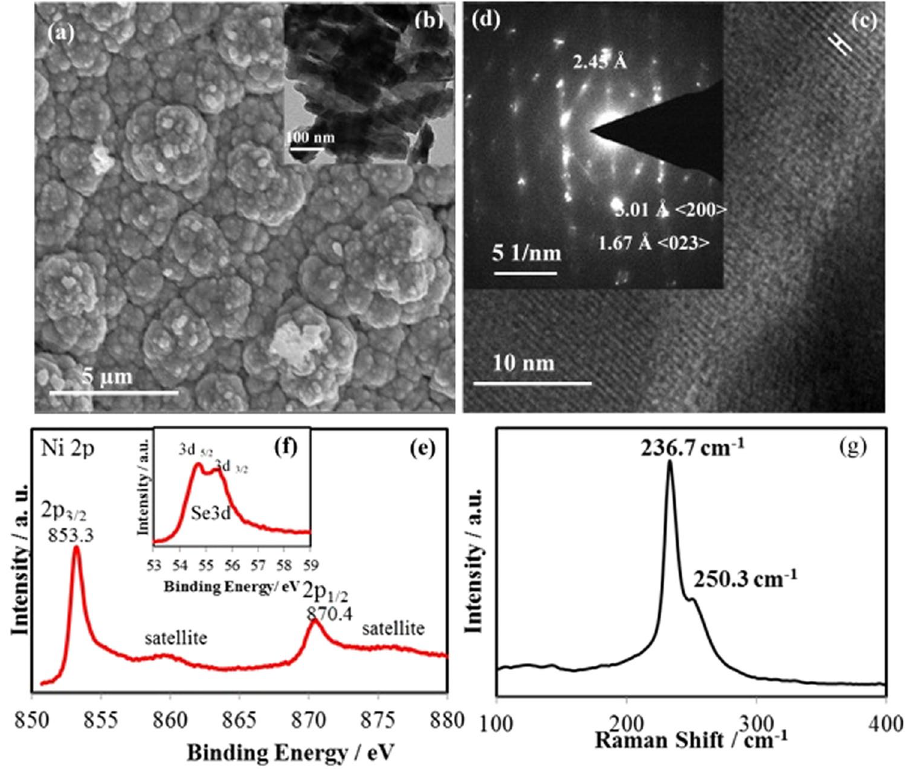
Figure 2. SEM ( a ) and TEM ( b ) images of electrodeposited NiSe 2 , ( c ) HRTEM image of the catalyst showing lattice spacing of 2.45 A corresponding to < 211 > lattice planes, ( d ) Typical SAED pattern showing characteristic diffraction spots, ( e ) XPS spectra of the catalyst showing the Ni 2p peaks, ( f ) XPS peaks corresponding to Se 3d. ( g ) Raman spectrum of the